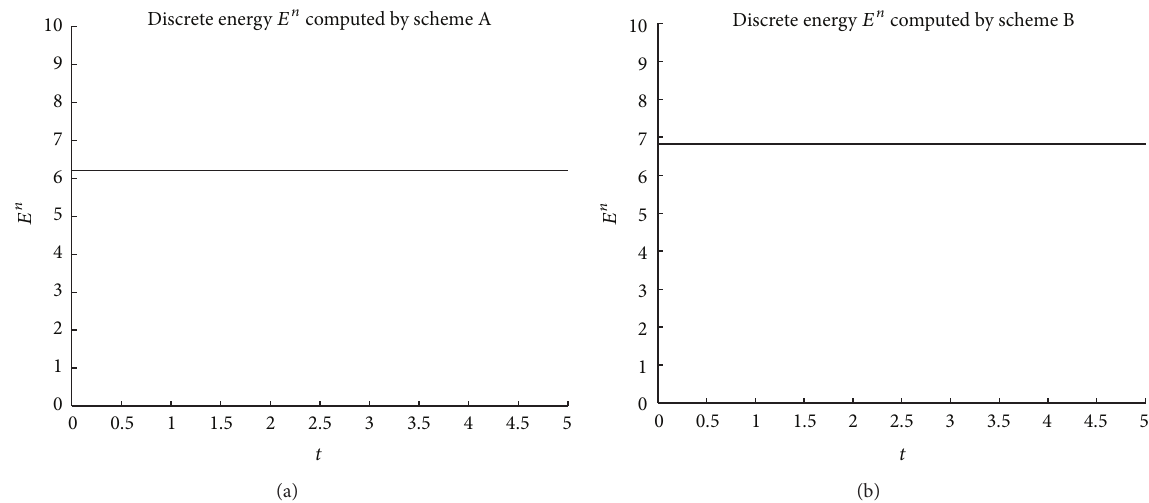
Figure 3: Discrete energy 𝐸 𝑛 computed by Scheme A and Scheme B with ℎ = 0.05, 𝜏 = 0.05.